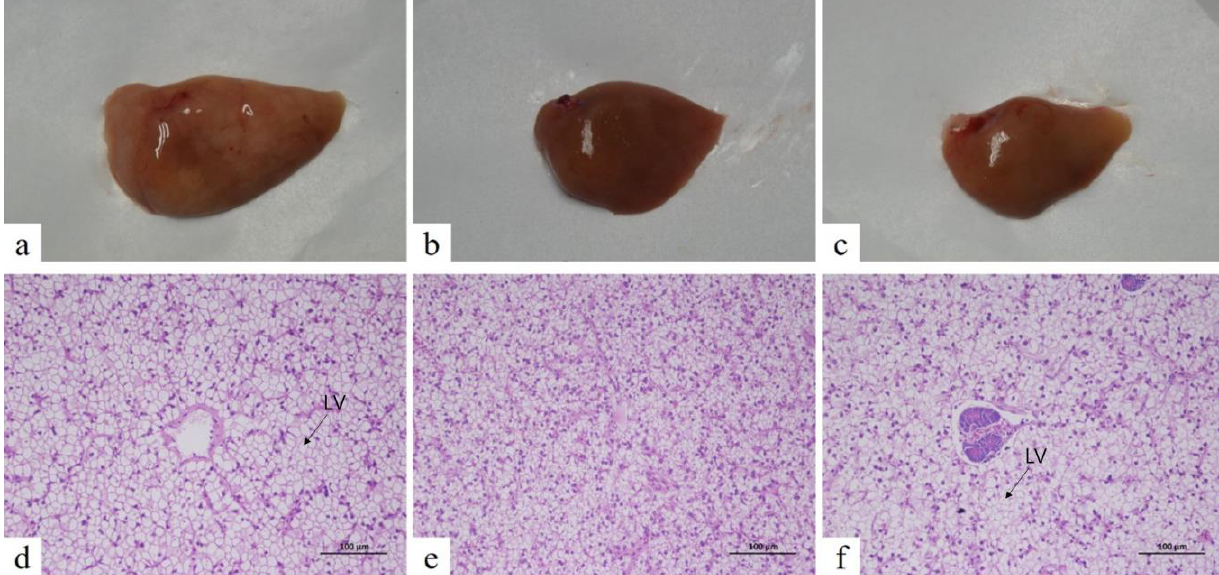
Figure 5. Effects of different levels of TM, instead of FM, on liver color and tissue structure in Micropterus salmoides. ( a ) Macrograph of liver in TM0 group; ( b ) macrograph of liver in TM24 group; ( c ) macrograph of liver in TM48 group; ( d ) paraffin section of liver in control group (200×); ( e ) paraffin section of liver in TM24 group (200×); ( f ) paraffin section of liver in TM48 group (200×). LV, lipid vacuole.